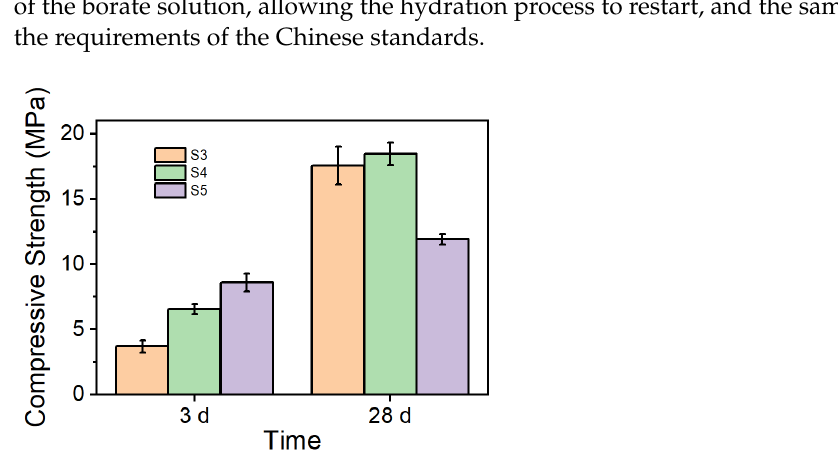
Figure 2. Compressive strength with S3, S4, and S5 samples hydrated 3 days and 28 days. Table 4. Compressive strength and durability of samples.